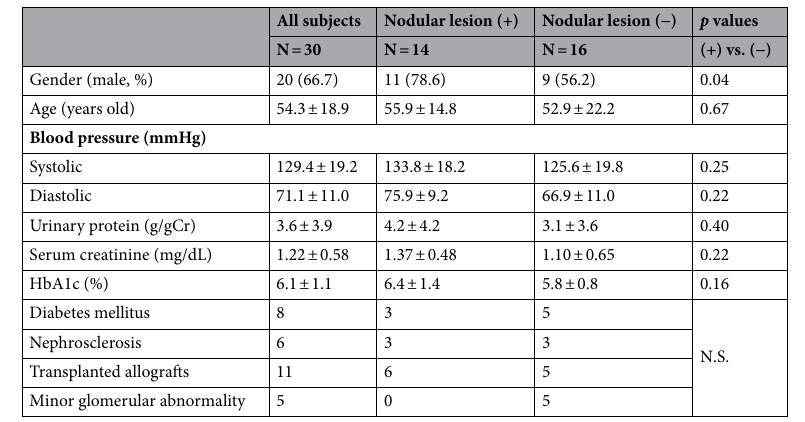
Table 1. Baseline characteristics of subjects. The population included 30 patients with or without nodular lesions. Values are means ± SD, N.S., not significant. Comparisons between groups were evaluated by the Mann–Whitney U